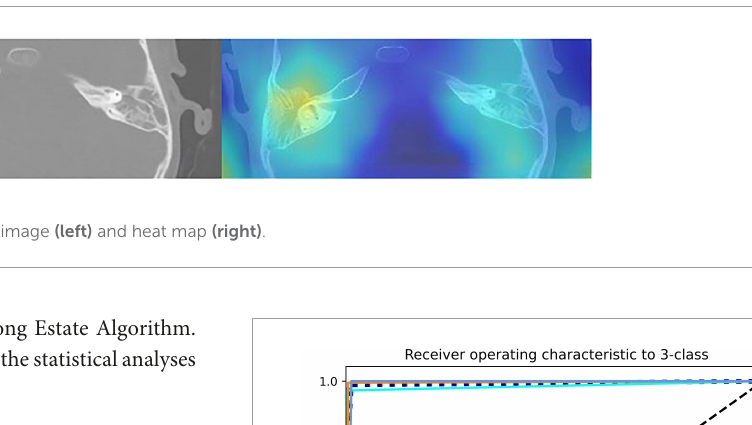
a 95% CI was estimated using the Tak Long Estate Algorithm.